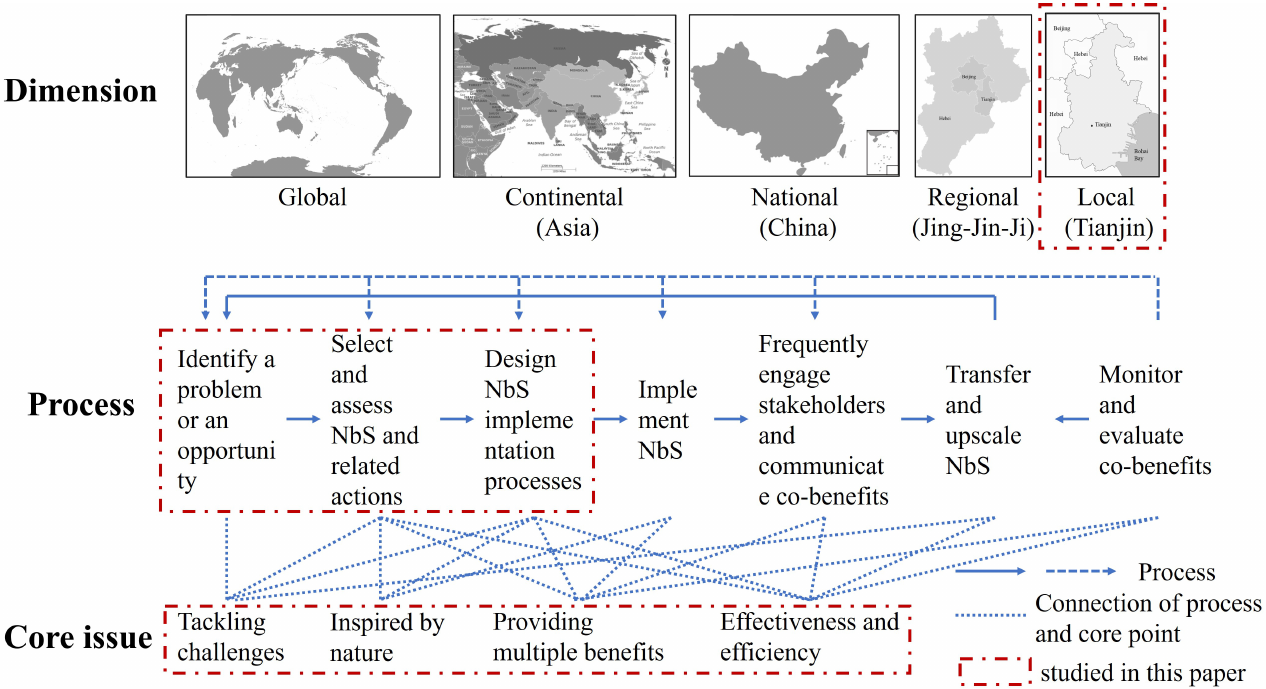
Figure 1. Process and core issues of NbS.